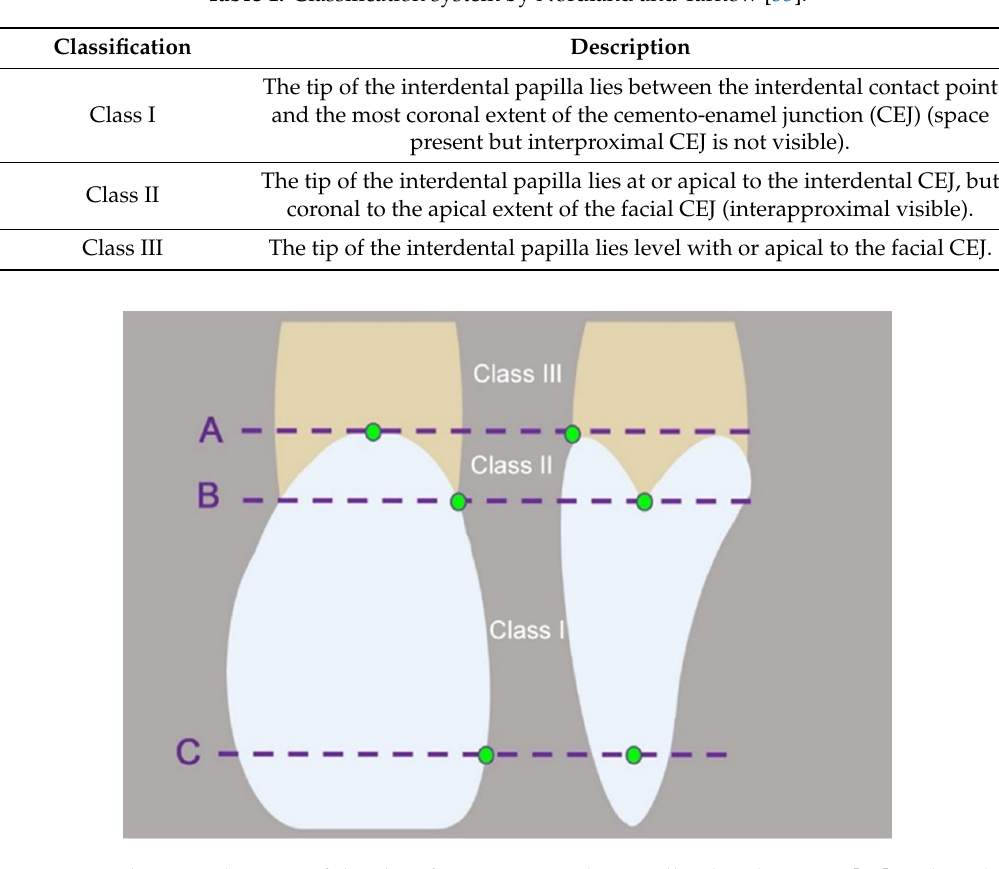
Table 1. Classification system by Nordland and Tarnow [35].